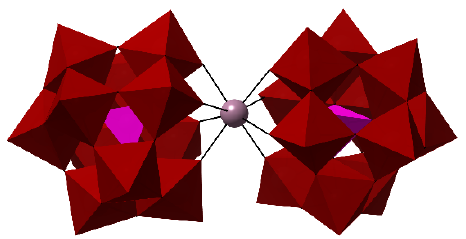
Figure 1. Polyhedral representation of (Et 2 NH 2 ) 10 [Zr( α -PW 11 O 39 ) 2 ] (Zr-K 1:2). WO 6 and PO 4 are represented by red octahedra and pink tetrahedra, respectively. The grey sphere represents Zr(IV) coordinated by Keggin units.